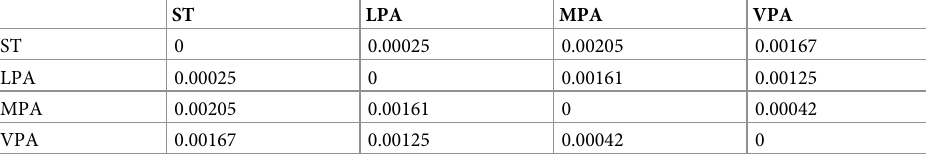
Table 3. Pair-wise log-ratio variation matrix for ST and PA in the full analytical sample (n = 2544). ST LPA MPA VPA ST 0 0.00025 0.00205 0.00167 LPA 0.00025 0 0.00161 0.00125 MPA 0.00205 0.00161 0 0.00042 VPA 0.00167 0.00125 0.00042 0 LPA, light-intensity physical activity; MPA, moderate-intensity physical activity; PA, physical activity; ST, sedentary time; VPA, vigorous-intensity physical